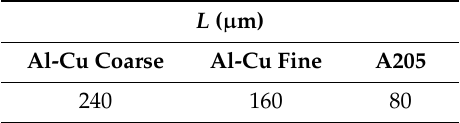
Table 4. Grain size values adopted from the measured